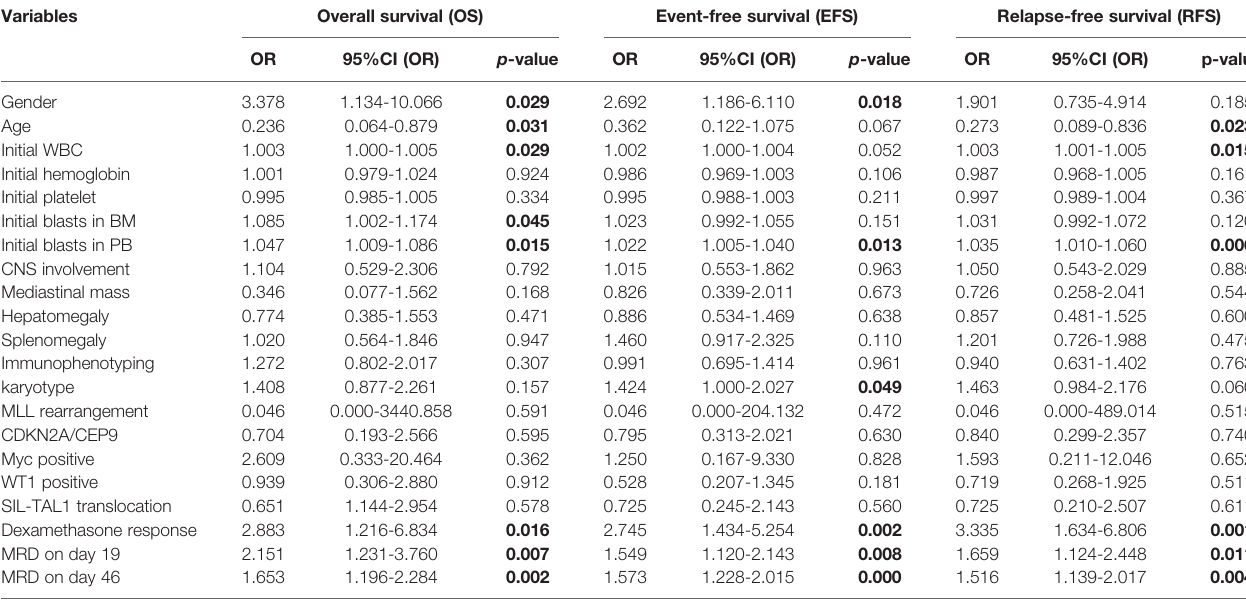
TABLE 3 | Univariate analysis of the relationship between various clinical indicators and survival of children with T-ALL. Variables Overall survival (OS) Event-free survival (EFS) OR p-value